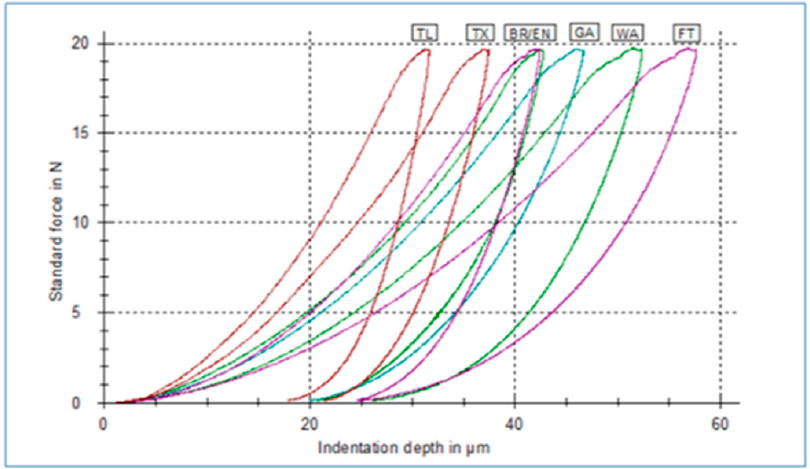
Figure 1. Representative force-indentation depth curves from all materials tested.